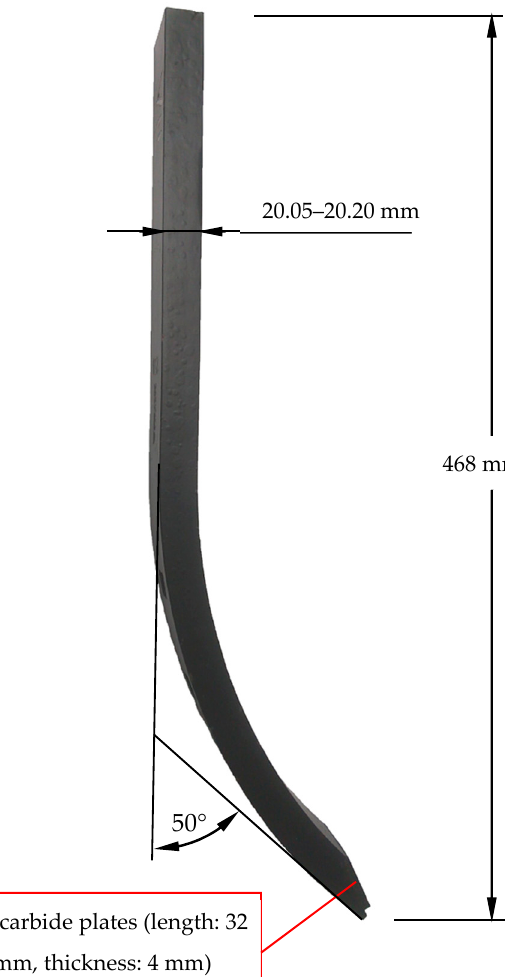
Figure 3. Distribution of tested elements on beams in a cultivation–sowing aggregate.